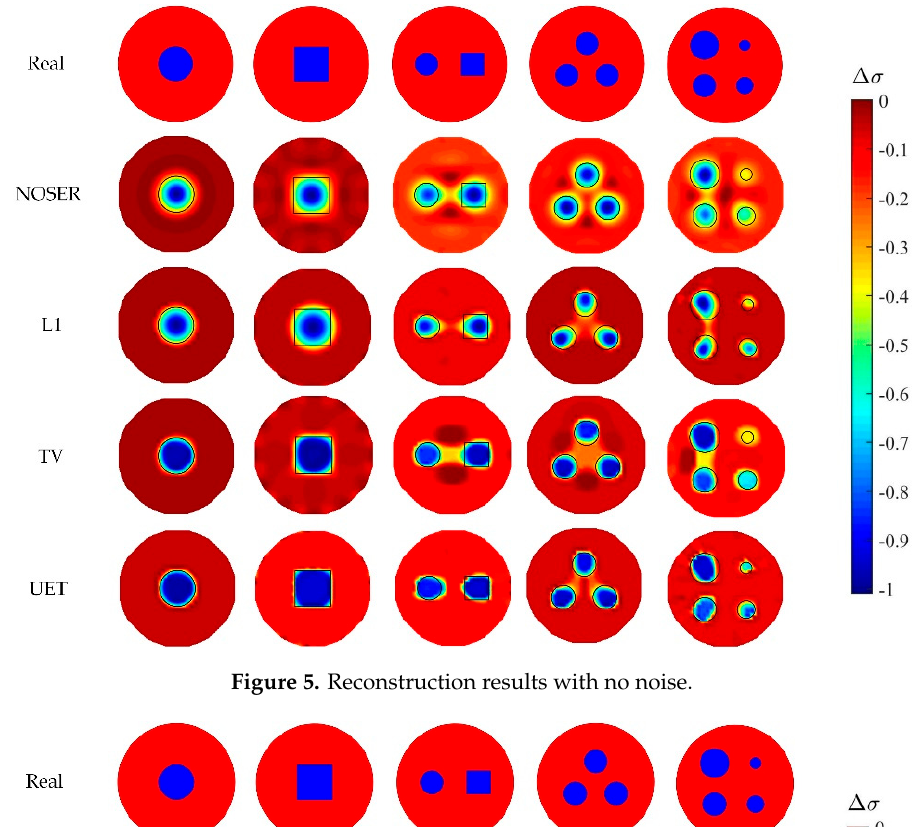
Figure 5. Reconstruction results with no noise.